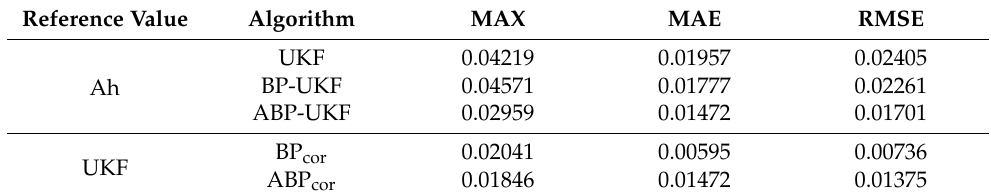
Table 3. Criteria for the SOC estimation results under the BBDST working